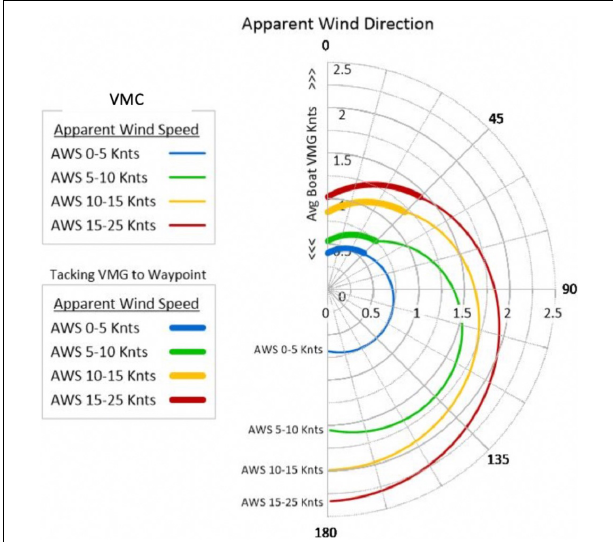
FIGURE 4 | A polar diagram illustrating averaged Nav2 velocity magnitude while sailing as a function of apparent wind magnitude and direction for all deployments. The four colors represent data for intervals for binned wind speeds. Between angles of 45 ◦ and 180 ◦ , the magnitude is the actual realized velocity over ground of the vehicle in the intended direction, or the “Velocity Made Good on Course.” The Nav2 tracks as does a traditional sailboat at wind angles < 45 ◦ , realizing VMG (“Velocity Made Good”), and the vessel makes significant forward progress even when traveling at very low angles relative to the wind.